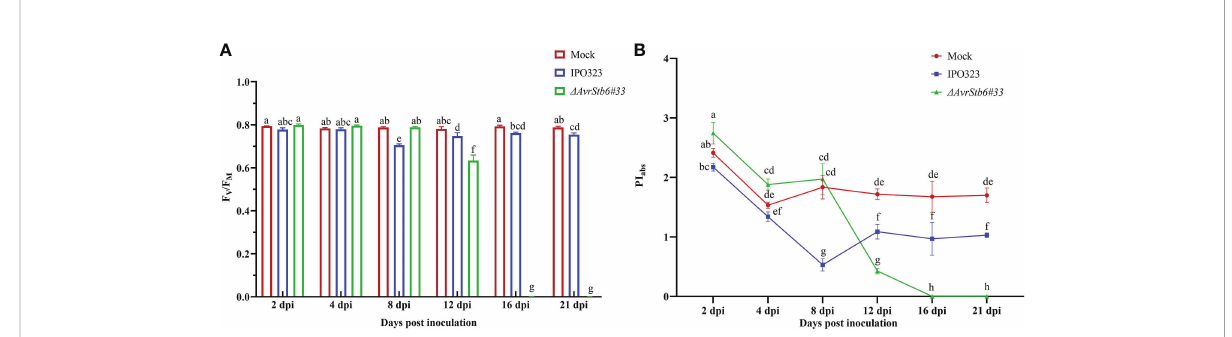
FIGURE 2 The impact of AvrStb6-Stb6 relationship on the maximum quantum yield of PSII (Fv/F M ) (A) and Performance index (PI abs ) (B) parameters. The leaves of cv. Sha fi r harboring Stb6 were inoculated with the WT IPO323 and AvrStb6#33 strains. The essential parameters to calculate the Fv/F M and PI abs were measured by a Fluorpen FP at several time points, including 2, 4, 8, 12, 16, and 21 days post-inoculation. Data are indicate as mean ± SD (Standard Deviation) of four biological samples from one independent experiment. Different lowercase letters indicate statistically signi fi cant differences (P ≤ 0.05).